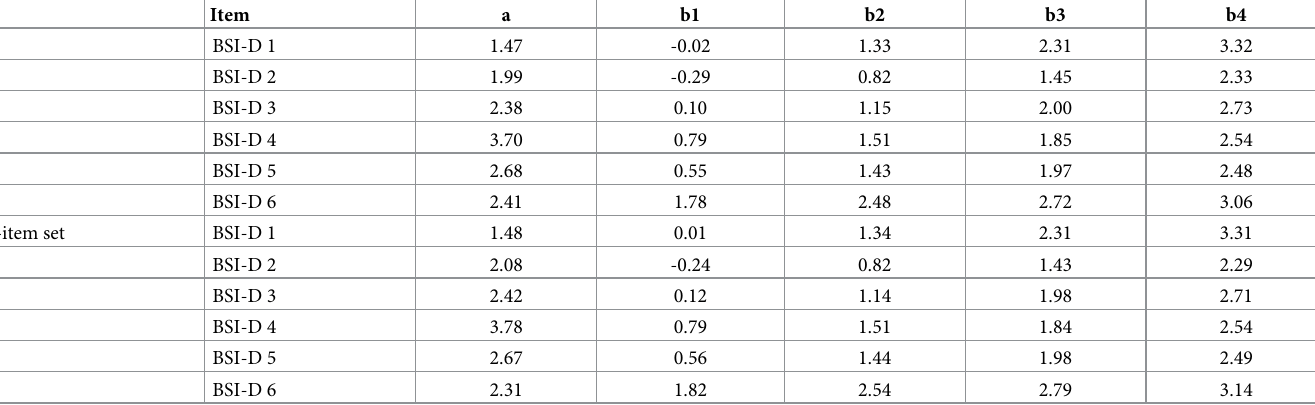
Table 3. Transformed IRT-based item parameters based on the linking of the BSI depression and the PROMIS depression 8a and the PROMIS depression 18-item set. Item